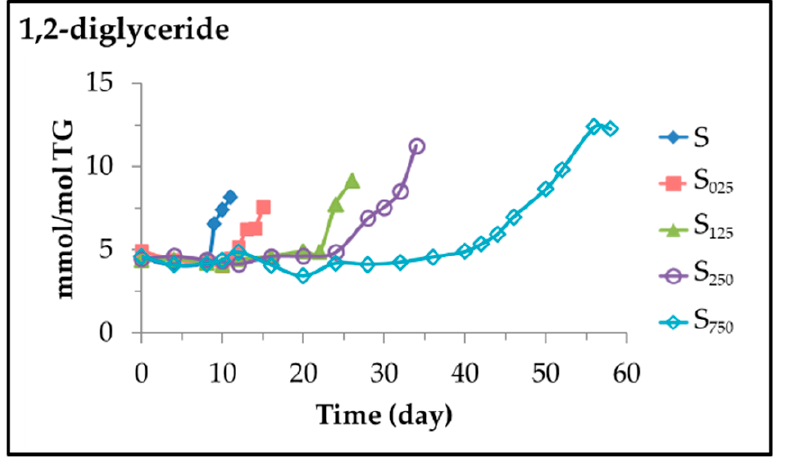
Figure 18. Evolution of the concentration, expressed in mmol/mol TG, of diglycerides in samples S 025 , S 125 , S 250 and S 750 over the storage time at 70 °C up to a very advanced oxidation stage.